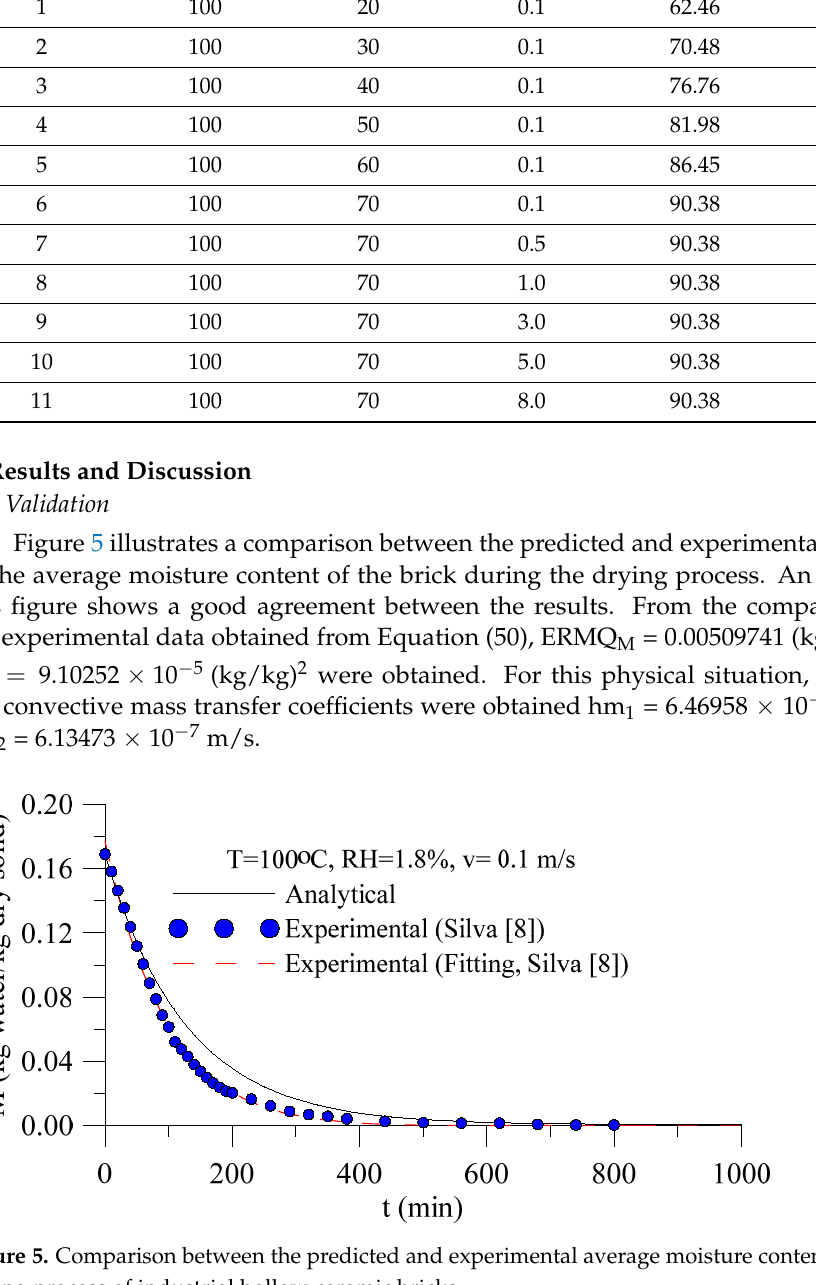
Table 6. Air and brick conditions used in drying simulations.